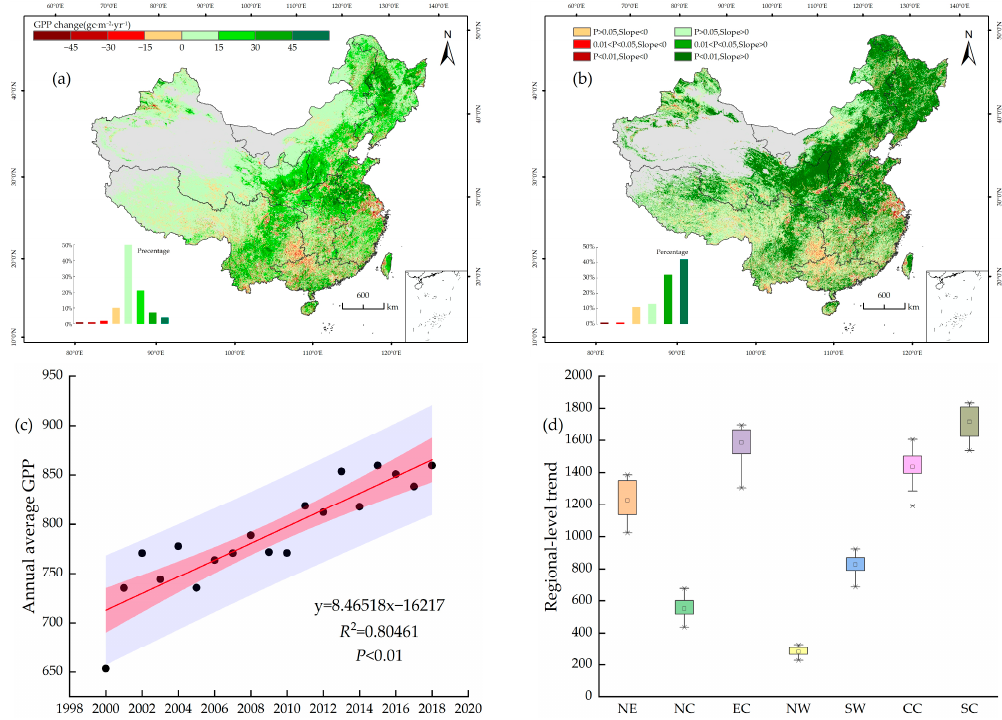
Figure 6. ( a ) Spatial distribution of the changes in the annual average GPP and ( b ) its significance level during 2000–2018. ( c ) Temporal changes in the country-level average annual GPP during 2000–2018. The red-shaded areas denote the 95% confidence interval. ( d ) Boxplots of regional-level statistics of the GPP trends in the seven regions.